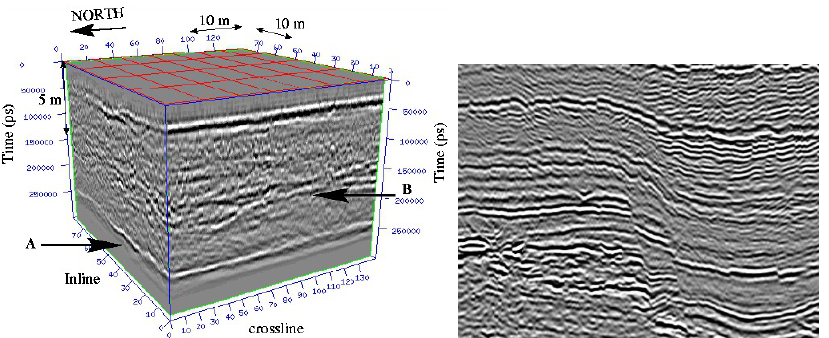
Figure 11. Left : 3D seismic dataset (courtesy of TotalEnergies, Pau, France). Two strong and continuous reflectors (Horizon A and Horizon B) appear. Right : 2D image (extracted from the 3D seismic dataset) with vertical faults and layers. Considering the complexity of such dataset, it is impossible to segment it without a priori given conditions. The segmentation process consists in finding layers and/or faults.